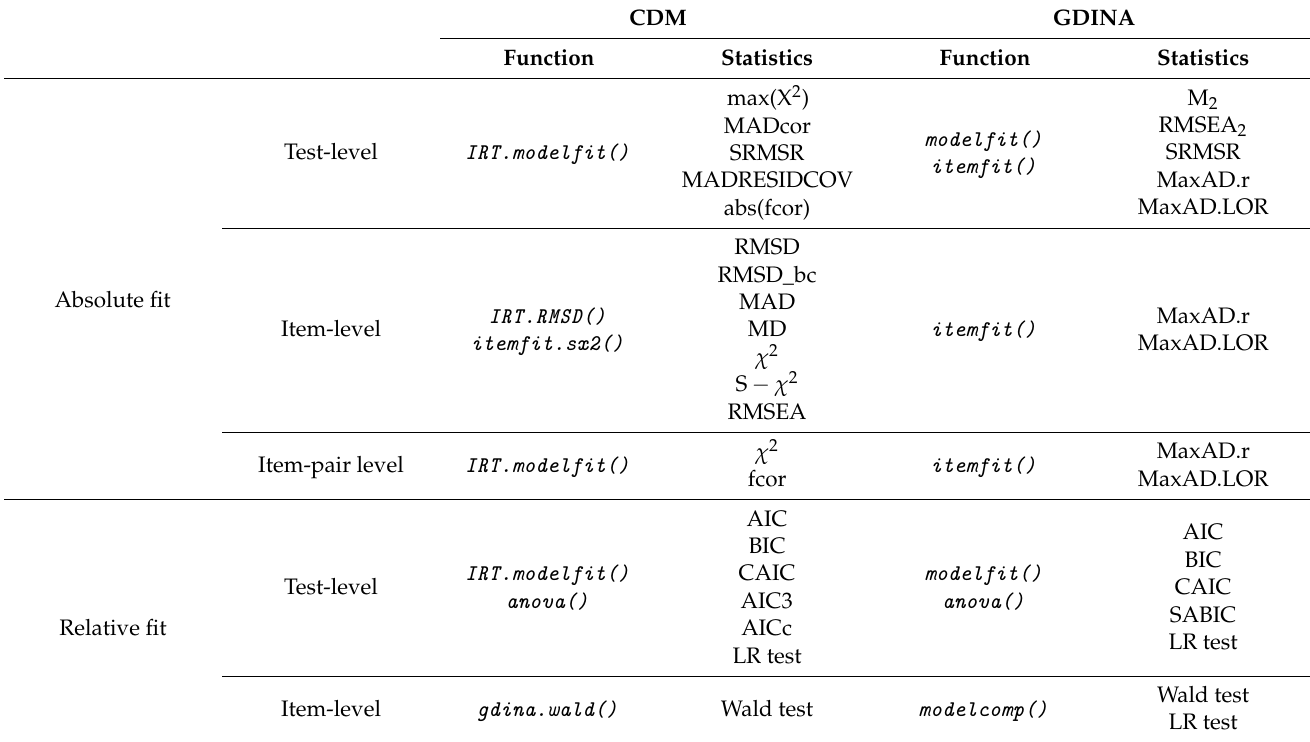
Table 2. Model-data fit